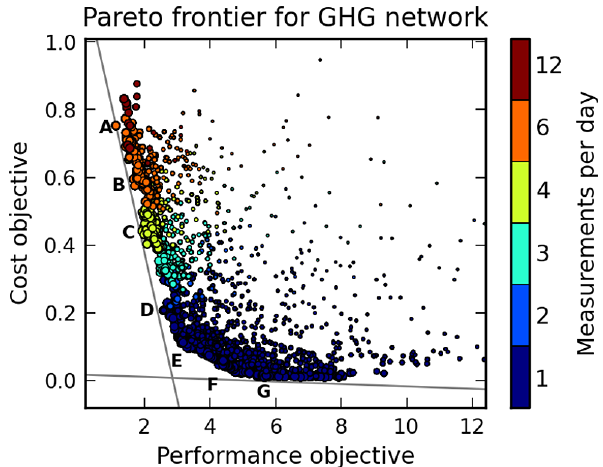
Figure 9. The figure displays the evolution the performance and cost objectives over generations of observing networks using MOGA. The stage of the evolution is denoted by circle size, with the earliest and latest generations corresponding to the smallest and largest circles, respectively. The measurement frequencies of the networks are color coded. Late generation points along the lead- ing edge represent the approximate Pareto frontier, and points A–G are described in the text. The gray lines approximate the tangents to the objective minima, and their intersection defines the “utopia” point.